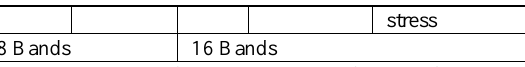
Table 4. List of 16 selected bands for classification.